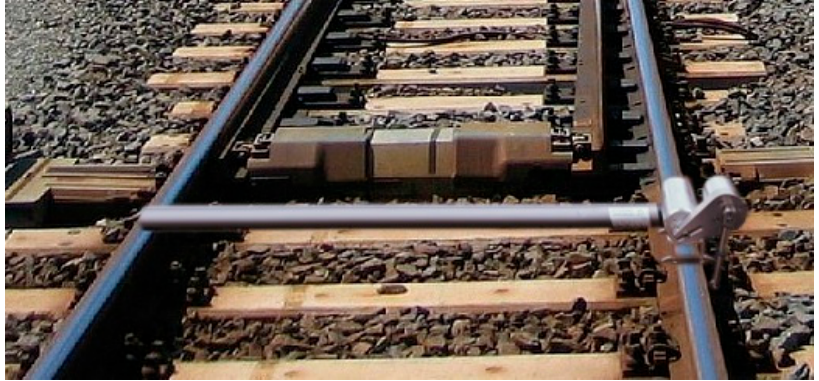
Figure 1. MiniProf Rail [35].